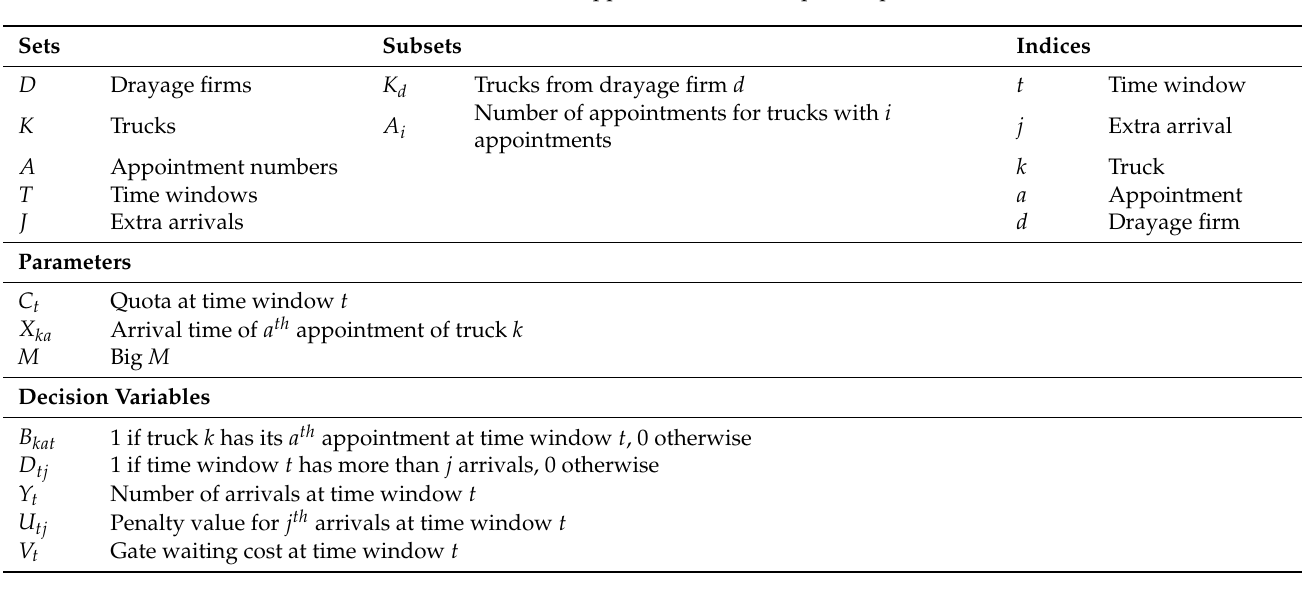
Table 3. Notation for the upper-level terminal operator